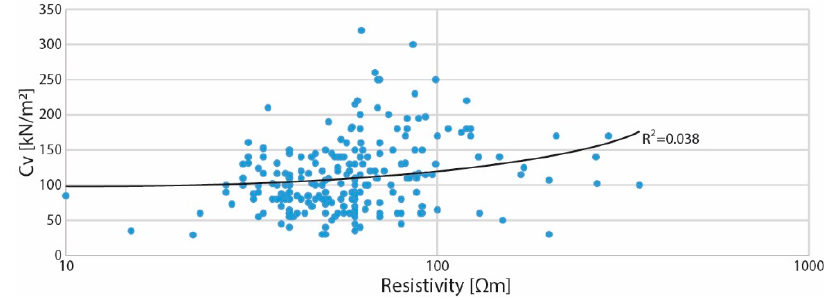
Figure 5. Resistivity plotted against the undrained shear strength of cohesive soils.